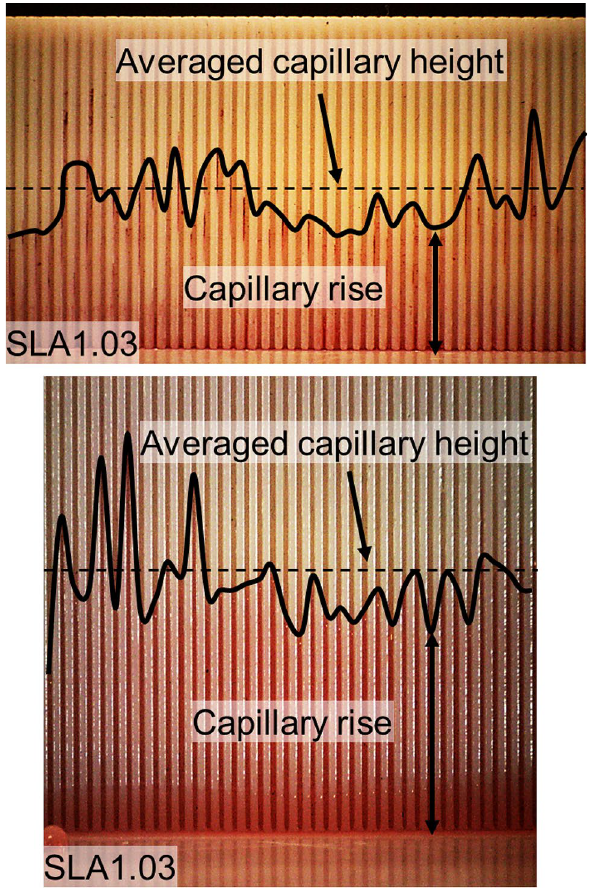
angle is 48.2 degrees. Dashed lines are an average height. Table 1 lists the sample details.